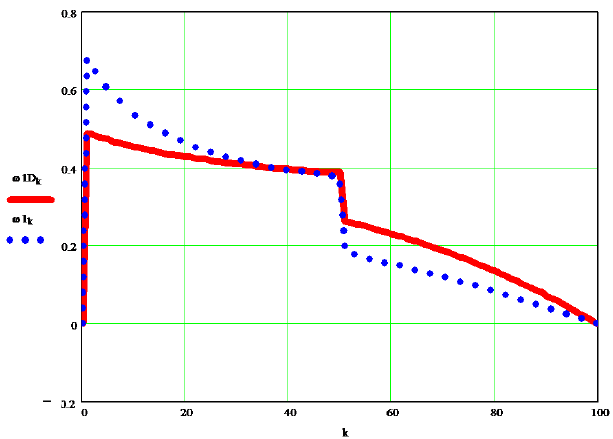
Figure 6. Variation of the dynamic angular velocity 2, depending on the independent parameter k .